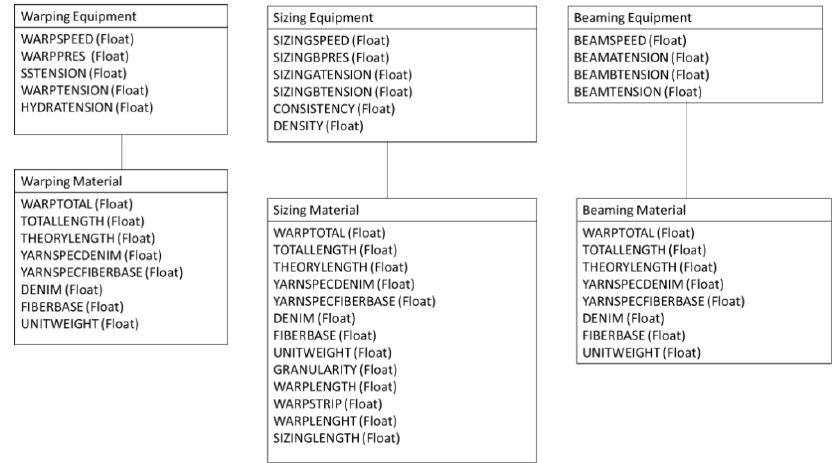
Figure 6. Data model in the textile manufacturing process.